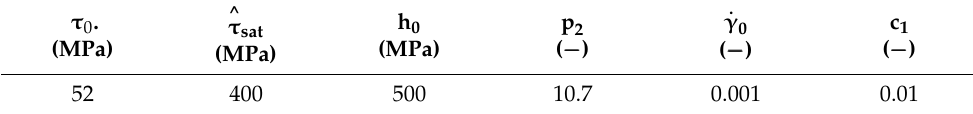
Table 1. The default value of considered material